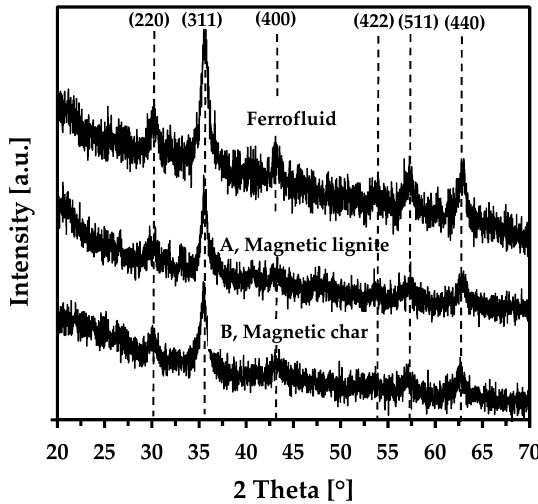
Figure 4. X-ray powder diffraction of the dried ferrofluid, magnetic lignite, and magnetic char (Miller indices for maghemite / magnetite are also indicated).